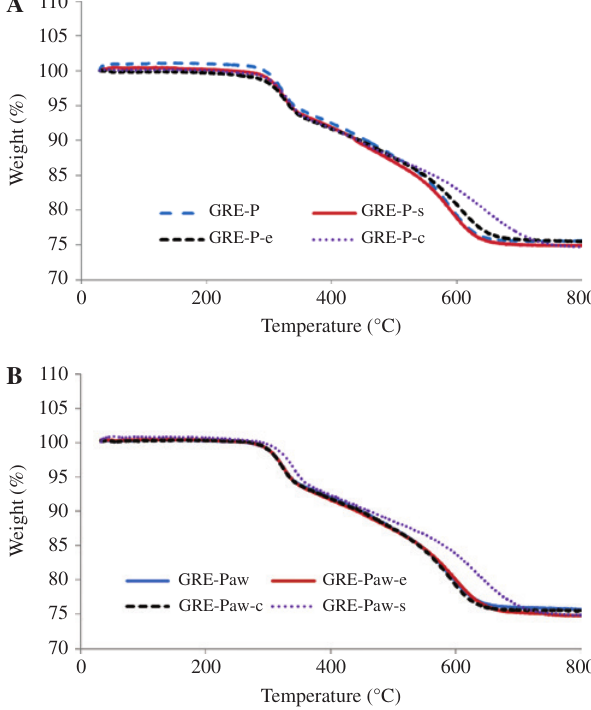
Figure 3: (A) TGA curves of GRE-P aged in different media for 60 days. (B) TGA curves of GRE-Paw aged in different media for 60